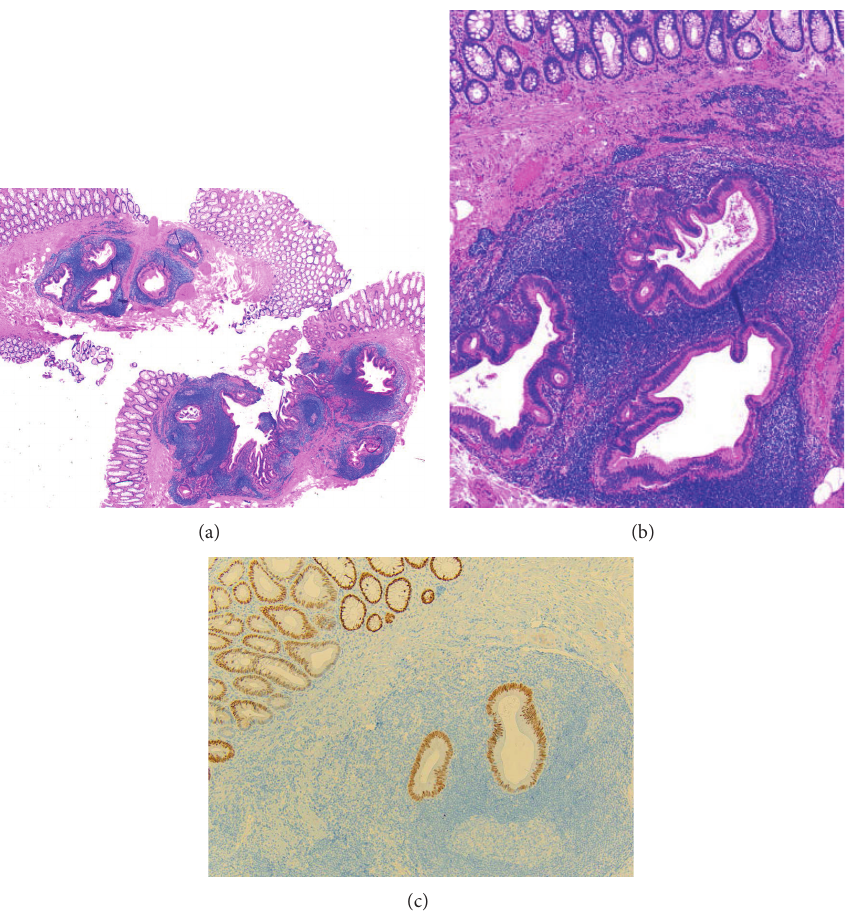
Figure 1: Pathologic findings. (a) At low power, an inverted growth of the cystically dilated glands with prominent lymphoid aggregates, similar to a greatly expanded lymphoglandular complex in the submucosa. (b) At higher power, the glands were lined by columnar epithelium with basally located small nuclei and reactive changes and surrounded by lymphoid aggregates. Note the absence of serrated tubular or adenomatous features or goblet cells. (c) Immunohistochemical staining showed the epithelial element was positive for CDX2 (CDX2